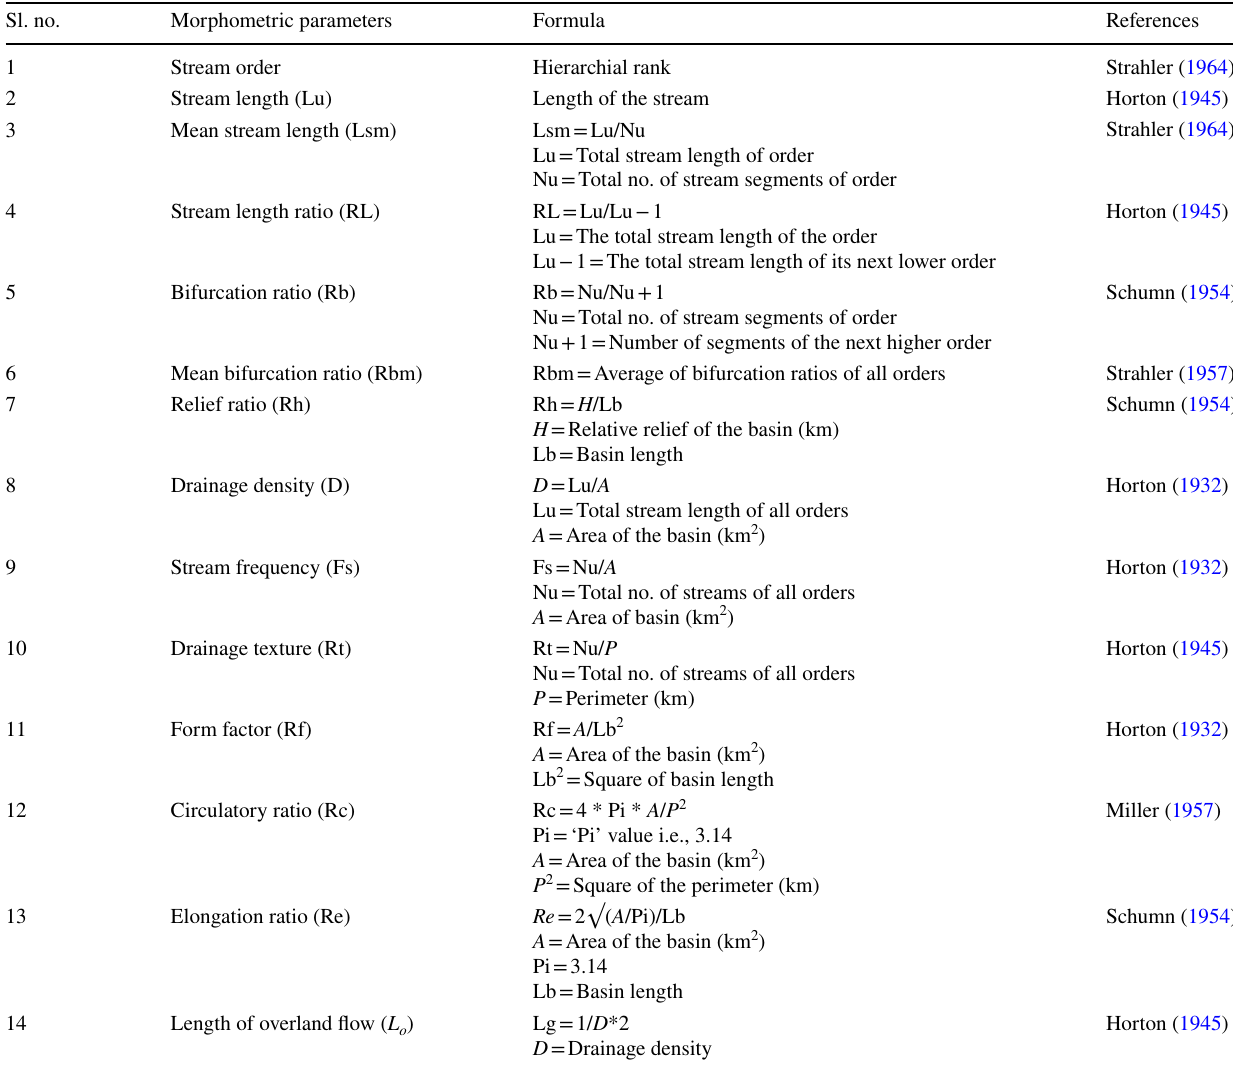
Table 1 Formulae adopted for computation of morphometric parameters Sl.